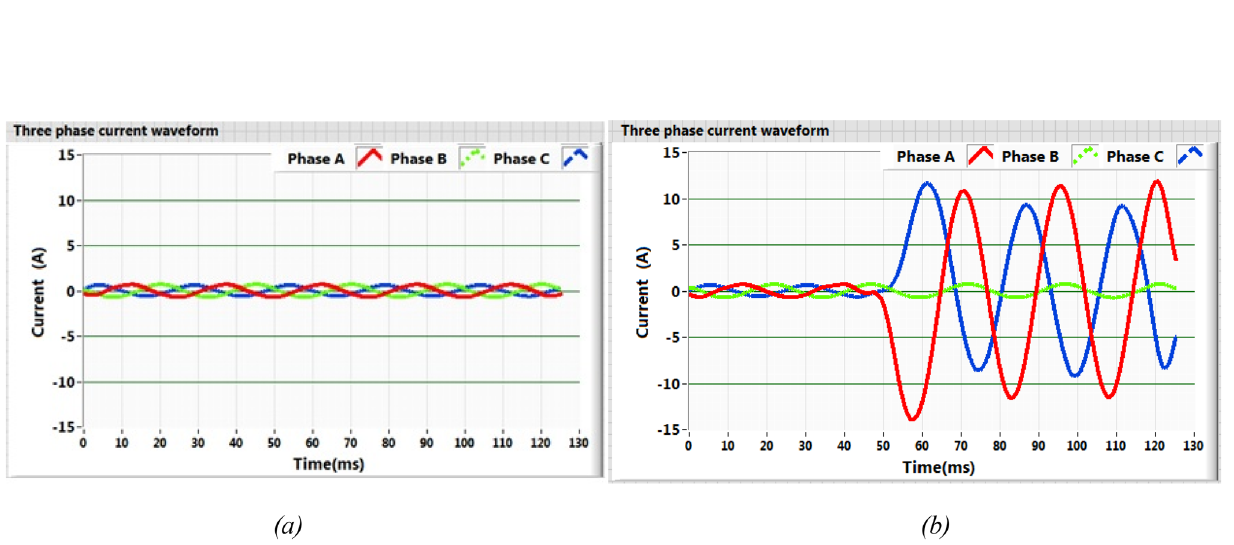
Fig. 3 Three-phase current waveform of a Normal operation b LLG